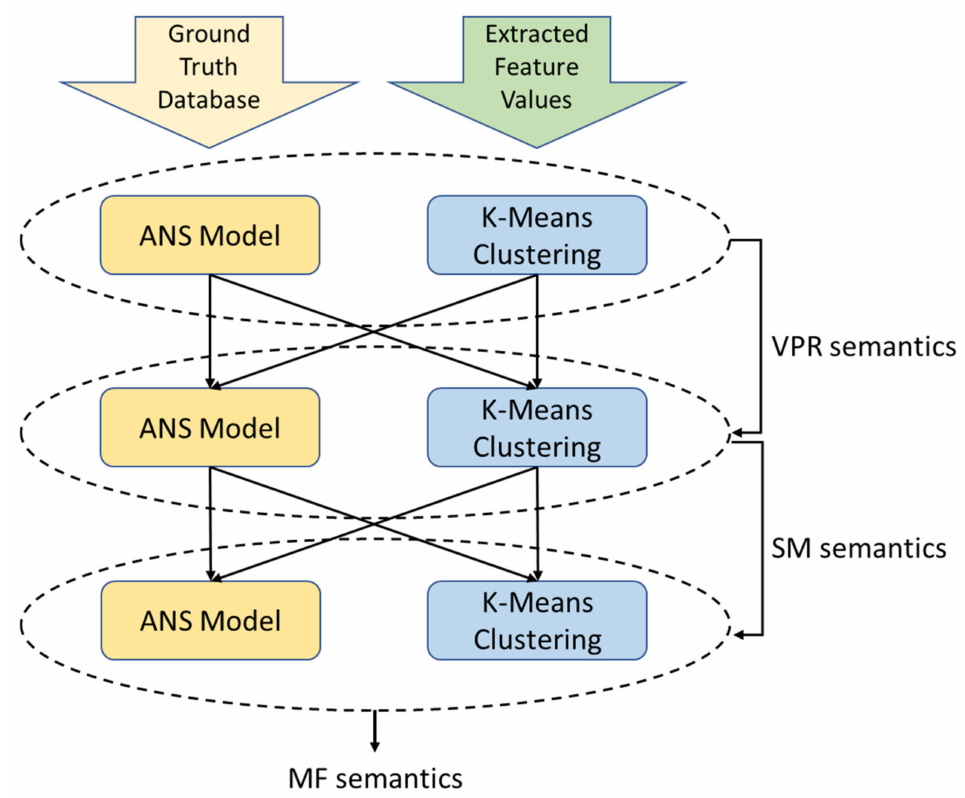
Figure 4. Description of classifier